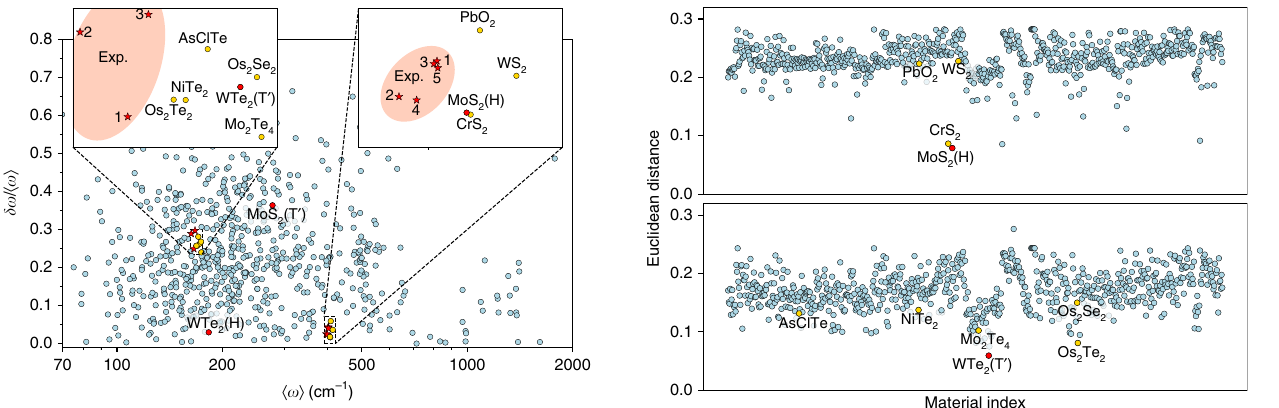
Fig. 7 Euclidean distances between Raman spectra. Distances (see main text for details) are calculated between theoretical Raman spectra and the experimental data of Tongay et al. 46 and Cao et al. 47 for MoS 2 (top) and WTe 2 (bottom). For comparison purposes, we highlight the points corresponding to materials in the insets of Fig. 6